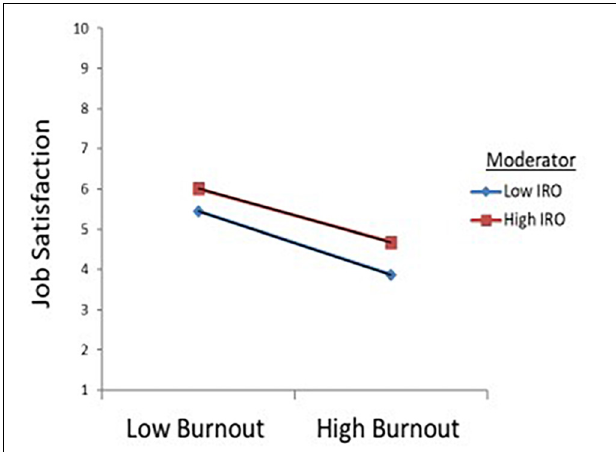
FIGURE 2 | The interaction between burnout and extrinsic religious orientation (ERO). TABLE 4 | Output of robustness analysis for IRO.